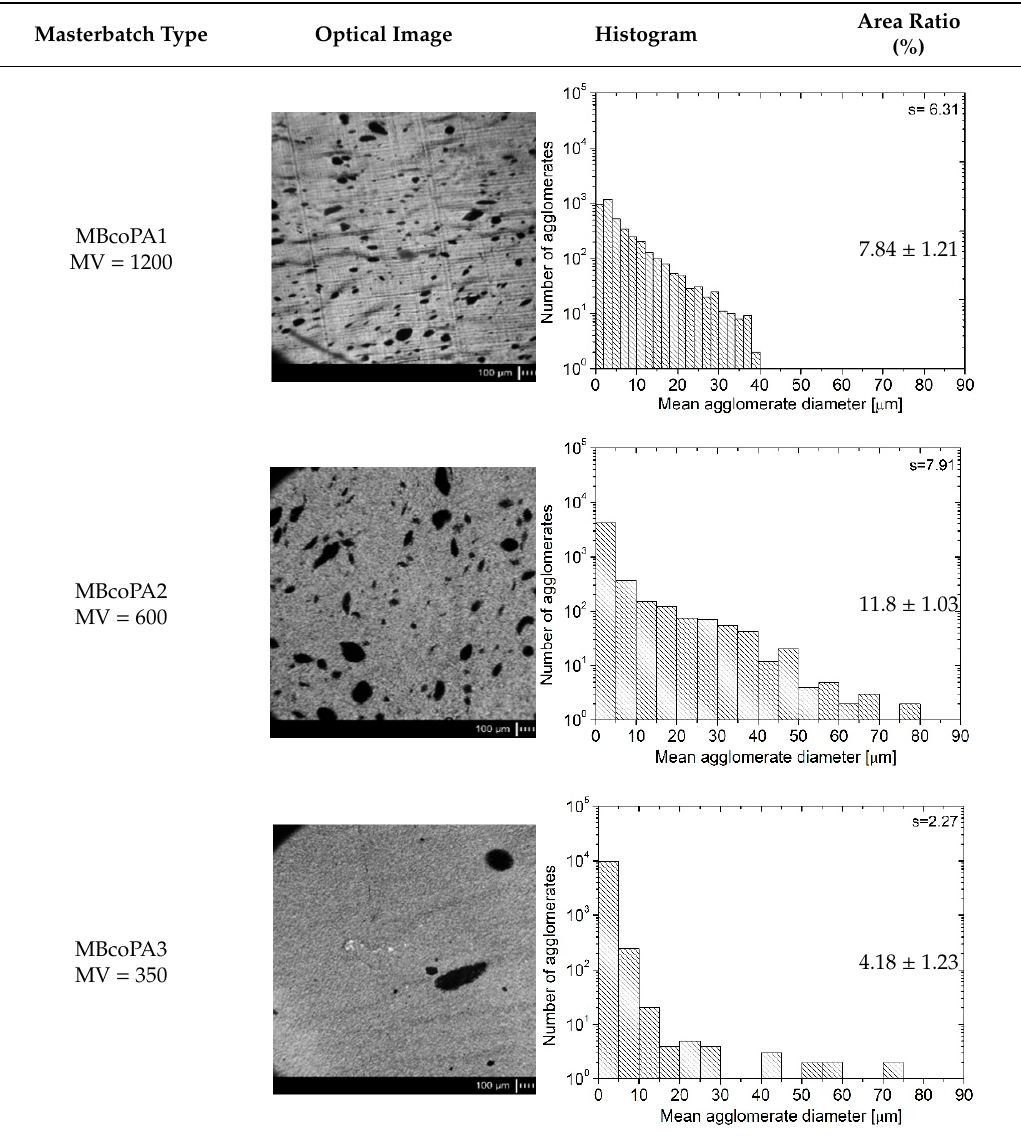
Table 2. The comparison of MWCNTs’ macrodispersion in the used coPAs expressed by agglomerates diameters and the area ratio. MV = melt viscosity in (Pa·s); s = standard deviation.